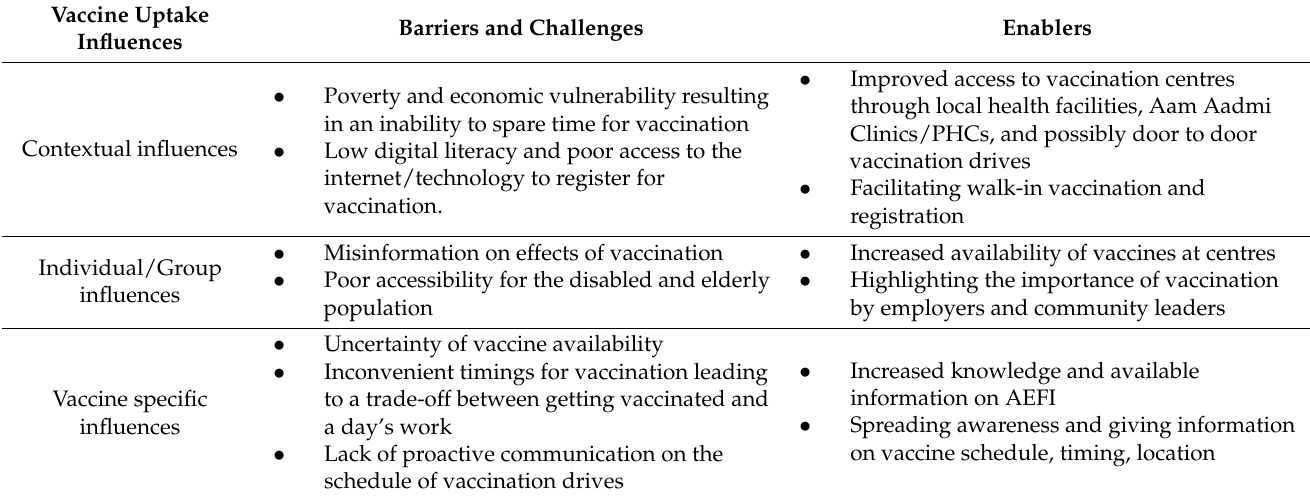
Table 18. Description of barriers and enablers to vaccine